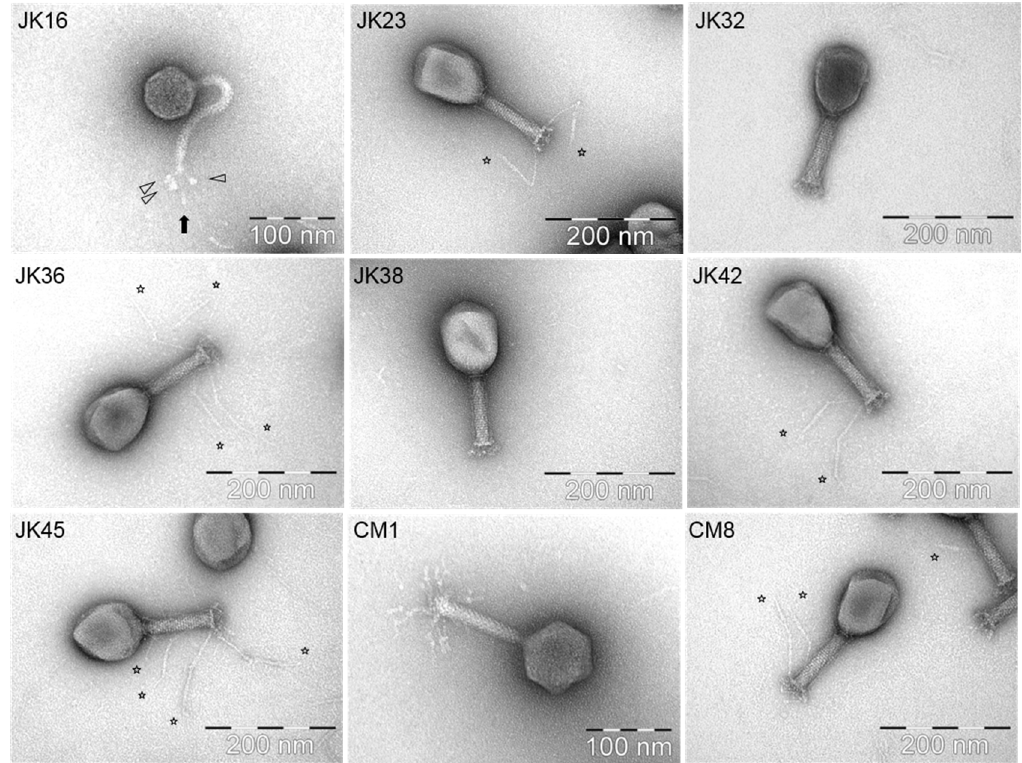
Figure 2. TEM morphologies of selected phages. Each phage name is indicated in the upper left corner of the picture while the scale is mentioned in the lower right. The star signs indicate the position of long tail fibers of the phages, while the arrow shapes in the JK16 picture point out the globular structures.